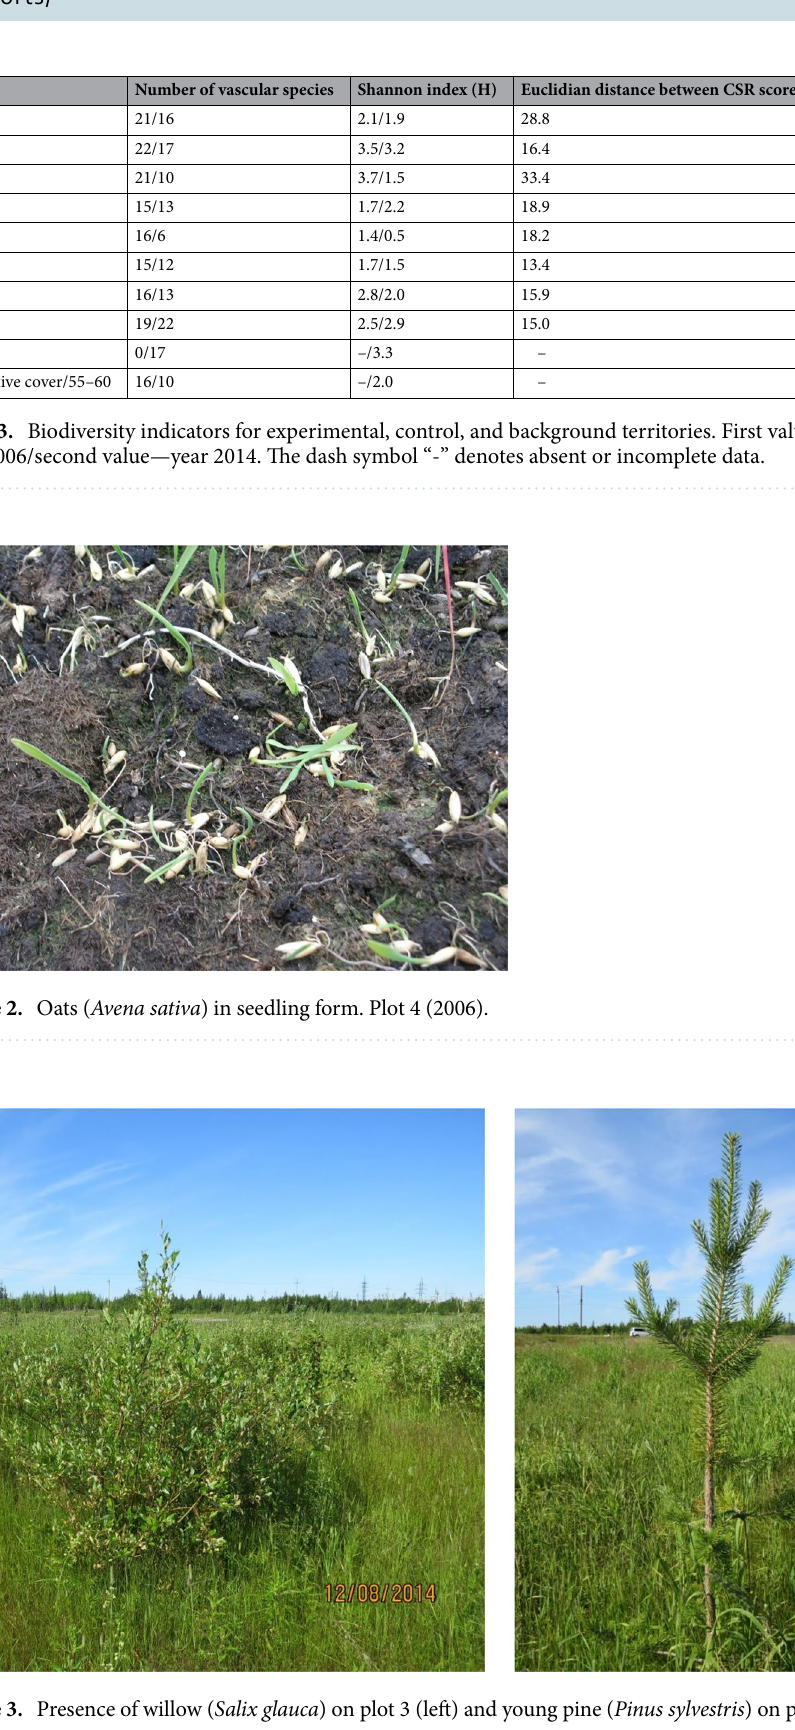
Figure 3. Presence of willow ( Salix glauca ) on plot 3 (left) and young pine ( Pinus sylvestris ) on plot 9 (right) in